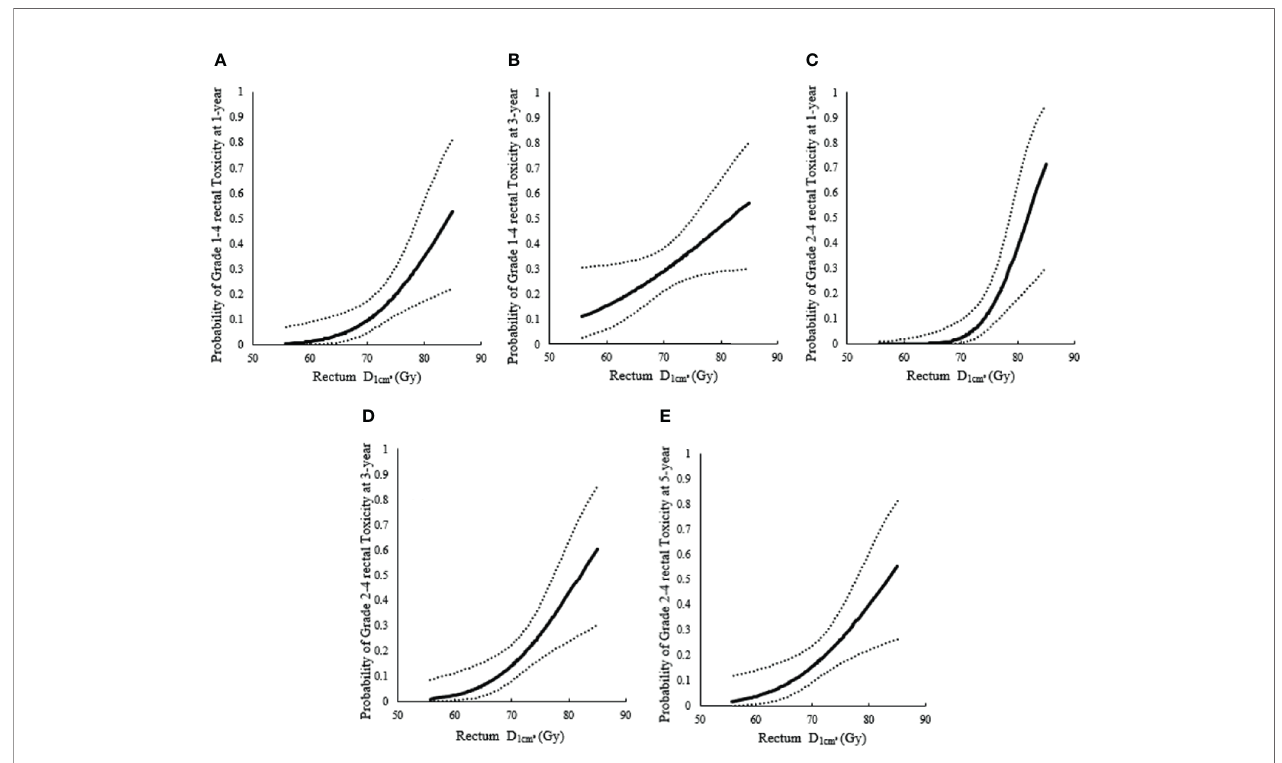
FIGURE 2 | Probit models between incidence of rectum morbidity with different grade for rectum. (A) Probit models between 1-year incidence of rectum morbidity with grade 1 – 4 and D 1cm 3 for rectum; (B) Probit models between 3-year incidence of rectum morbidity with grade 1 – 4 and D 1cm 3 for rectum; (C) Probit models between 1-year incidence of rectum morbidity with grade 2 – 4 and D 1cm 3 for rectum; (D) Probit models between 3-year incidence of rectum morbidity grade 2 – 4 and D